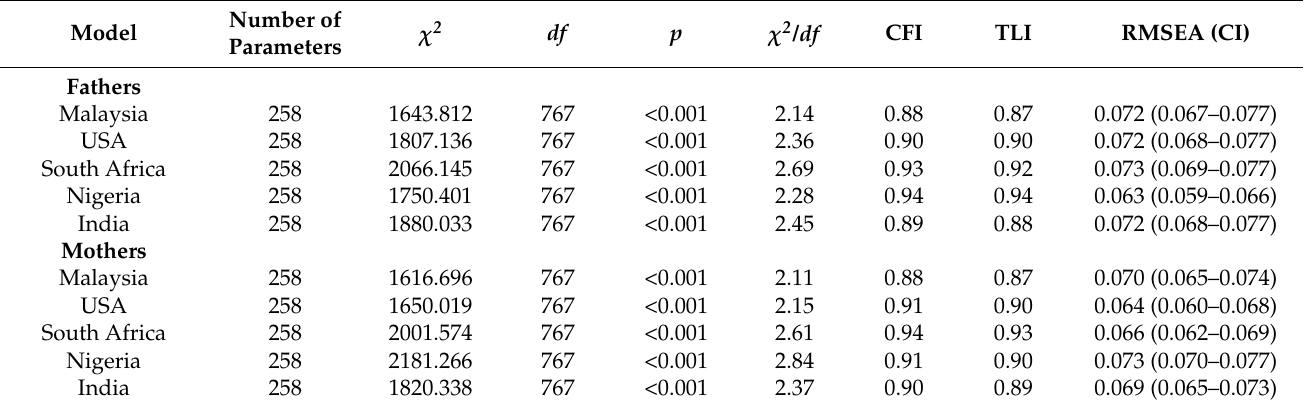
Table 5. CFA results for Three-Factor Second Order Solution for